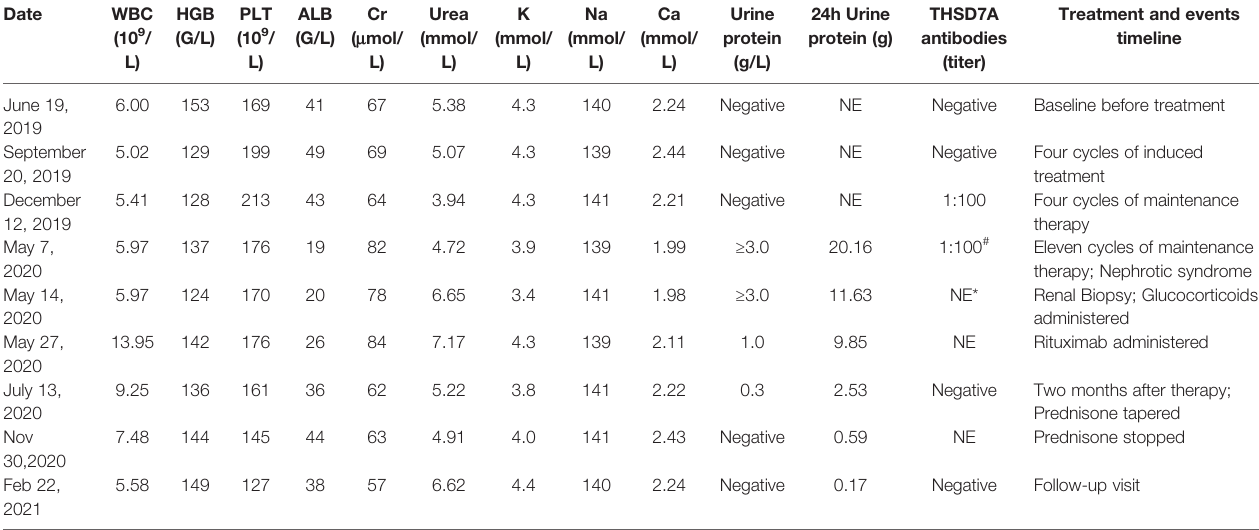
TABLE 1 | Laboratory values and treatment